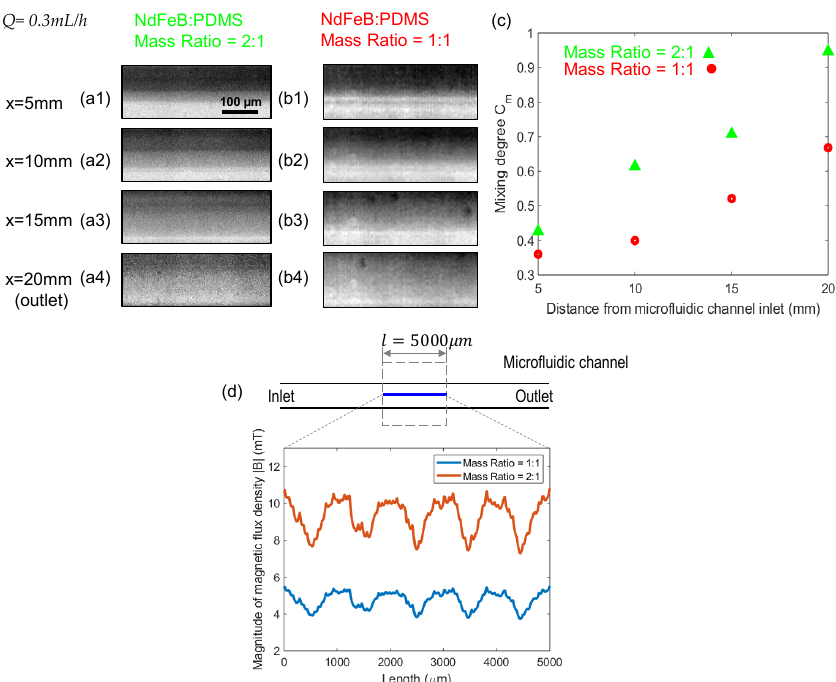
Figure 8. ( a ) E ff ect of the mass ratio of NdFeB:PDMS micromagnet on the mixing performance. Group ( a , b ) are the original experimental fluids distribution at di ff erent positions of the microfluidic channel under the e ff ect of magnetic field generated by the embedded micromagnet when its mass ratio